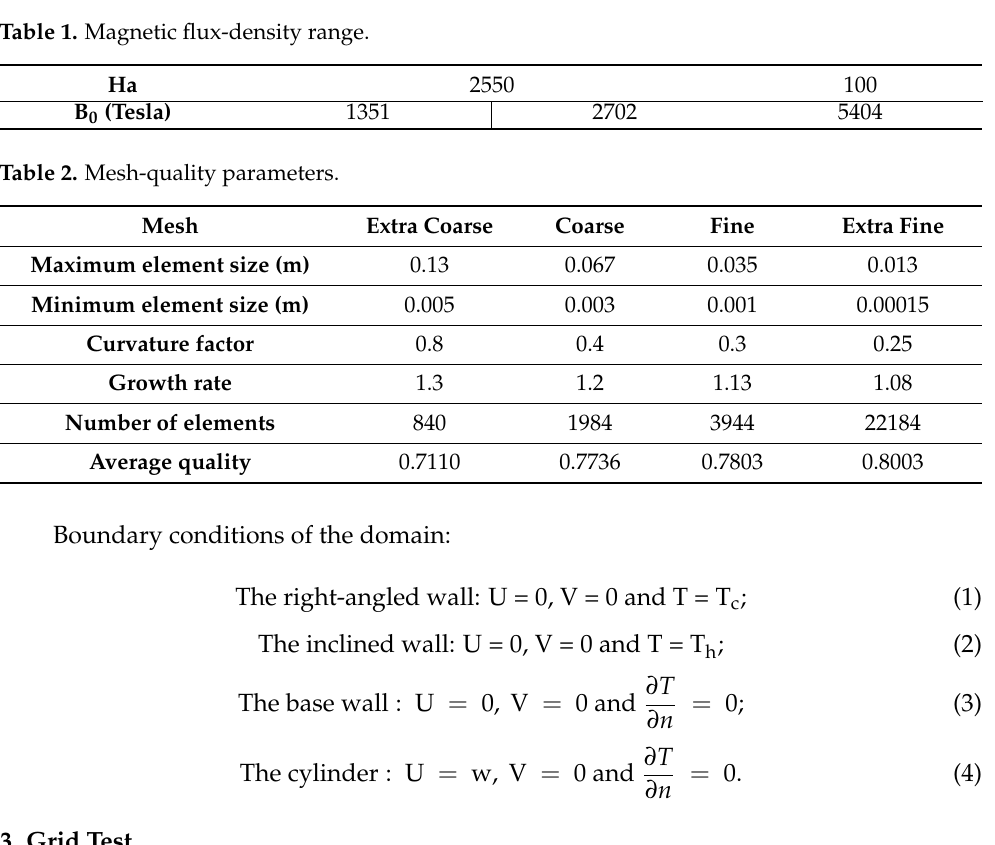
Table 3. Grid-independence test.